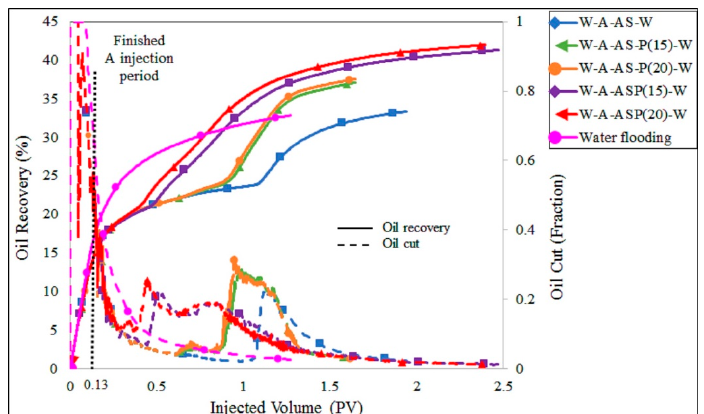
Figure 4. Oil production performance of water flooding and the sequences of the (A) group. The injections of a buffering ASP solution after the first alkaline flooding prove to be more efficient than using an AS slug with a buffering polymer solution, whereas the sequence without a buffering viscous fluid results in the worst performance owing to the severe oil bypassing mechanism.